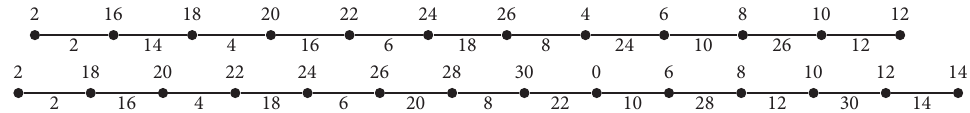
Figure 3: A 3-edge even graceful labeling of the path graphs P